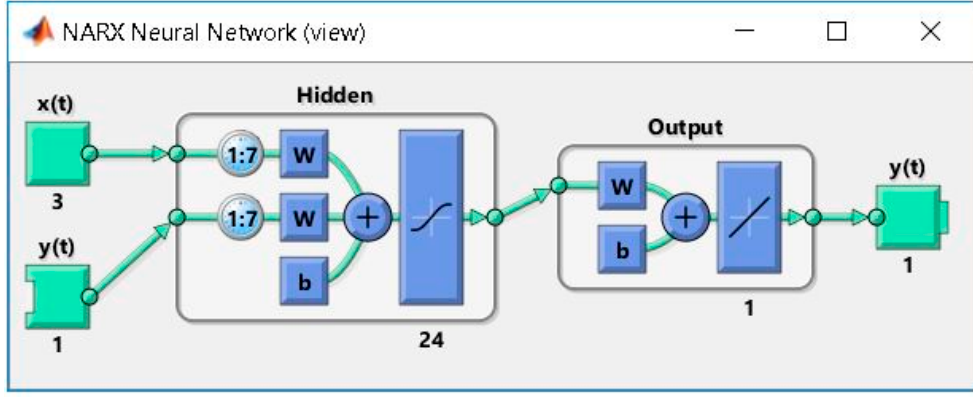
Figure 2. The architecture of the BEST_ non-linear autoregressive with exogenous inputs (NARX) network.